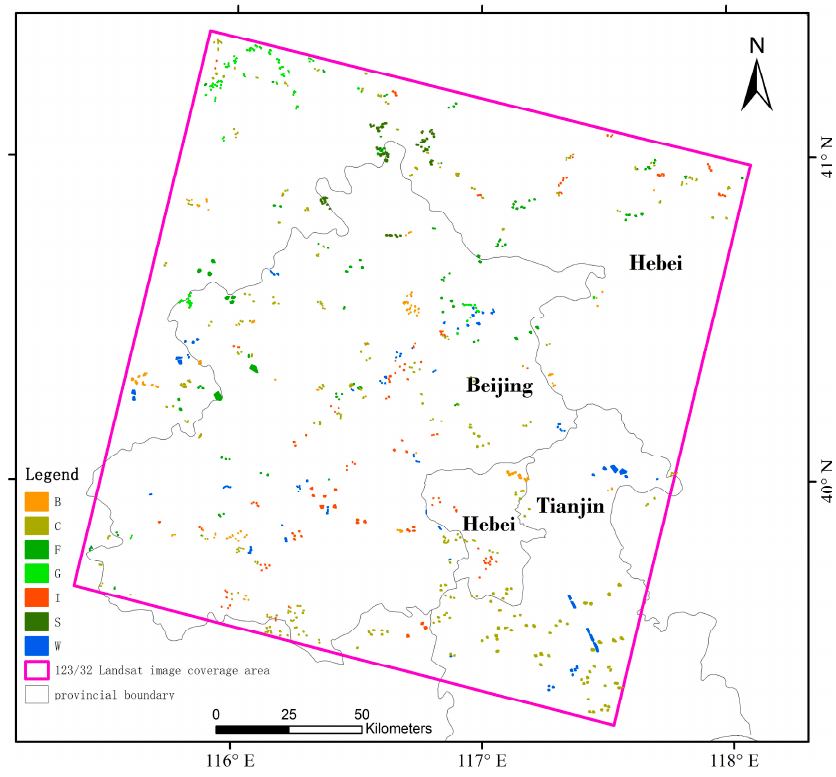
Figure 1. 123/32 Landsat image coverage area and sample polygons for each LULC type. (Note: